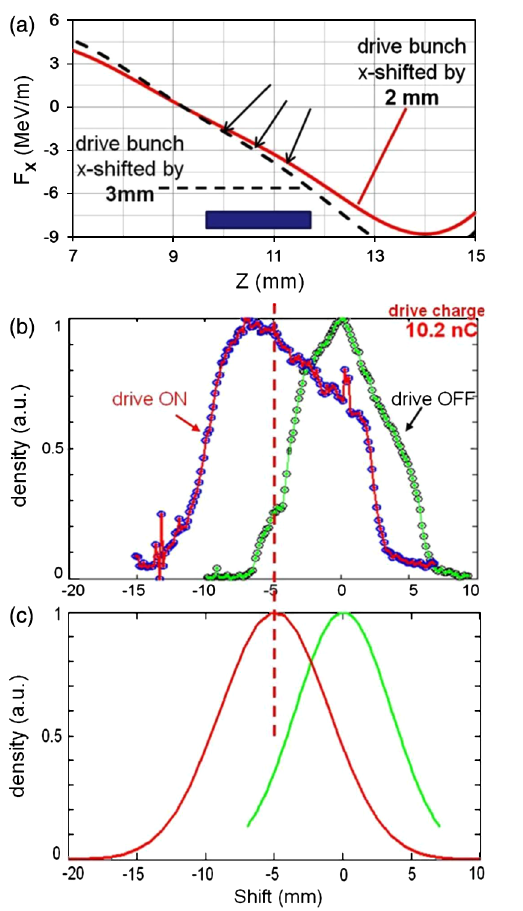
FIG. 15. (a) Simulations of F x for the test channel. (b) Typical bunch horizontal distribution (observed in 80%–85% of shots, normalized to 1) for the delay was 5.7 mm. (c) Simulations that predict changes in the horizontal distribution [for case #1 in Tables V and VI, for the drive bunch being shifted off the center of its respective channel by 2 mm (toward the test channel)].